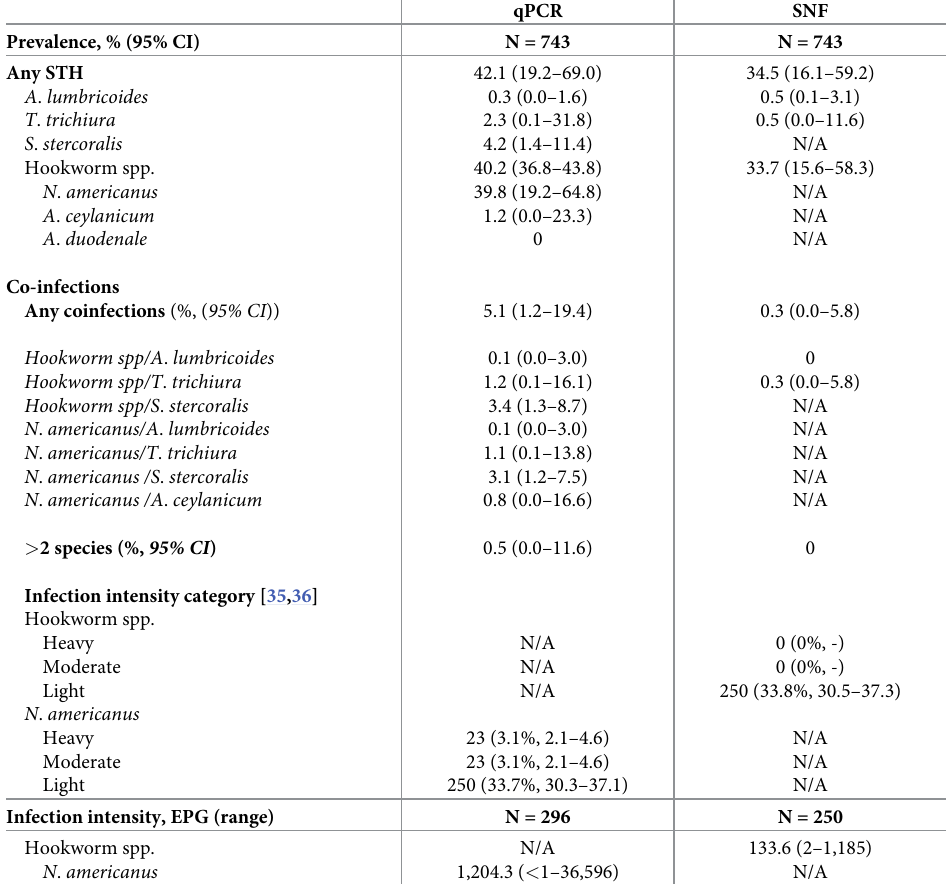
Table 1. Prevalence and infection intensity of different species of STH before albendazole treatment by qPCR and